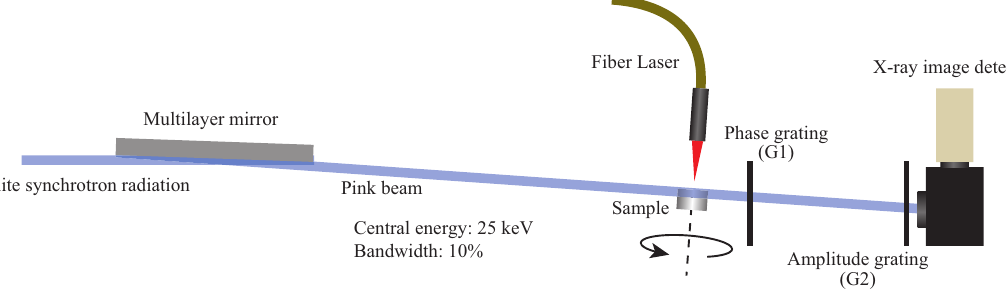
Figure 5. Experimental setup (side view) of pink-beam 4D phase computed tomography (CT) for observing a sample under laser